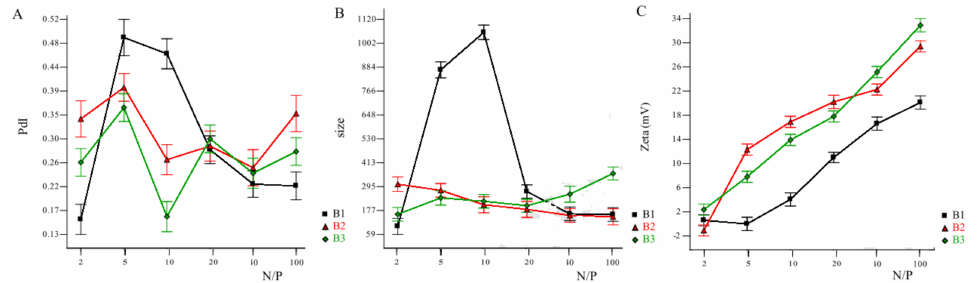
Figure 5. Effects of chitosan Mw and N/P ratio on ( A ) PDI, ( B ) hydrodynamic size, and ( C ) zeta potential of nanoplexes. B1 (cid:4) , B2 (cid:78) , and B3 (cid:7) are chitosan Mw of 9, 18, and 45 kDa, respectively. Reprinted with permission from ref. [25]. Copyright 2015 Int. J. Biol. Macromol.